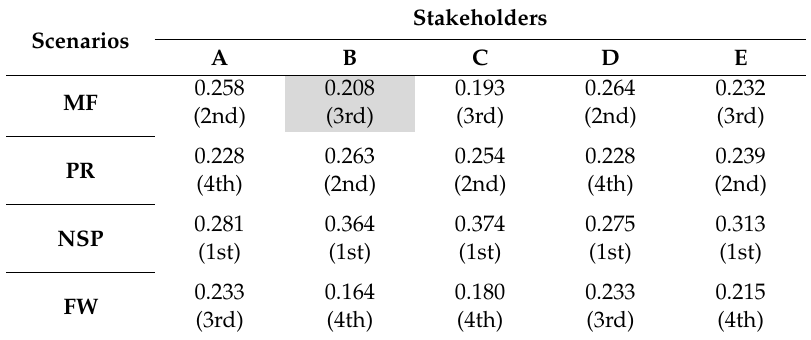
Table 11. Preferability indexes and ranking for the CE scenarios for each